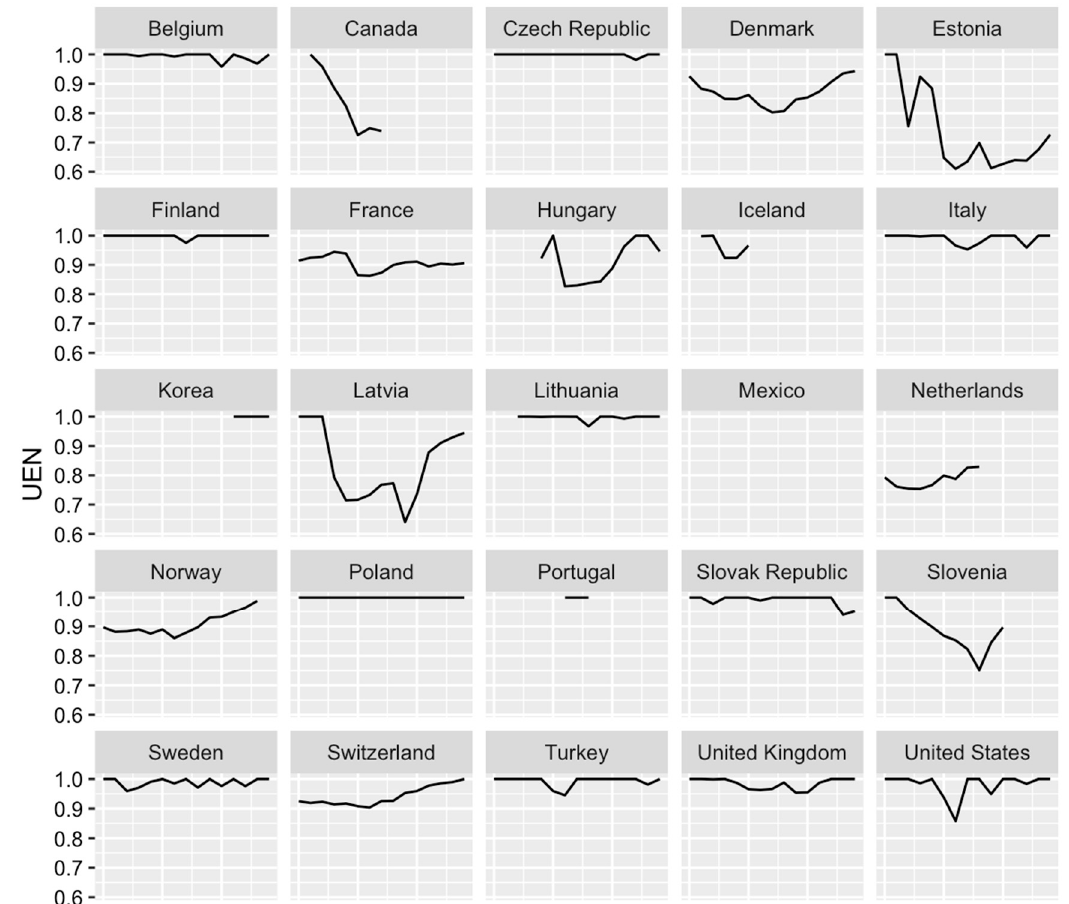
Figure 1. Evolution of UEN for 25 OECD countries.